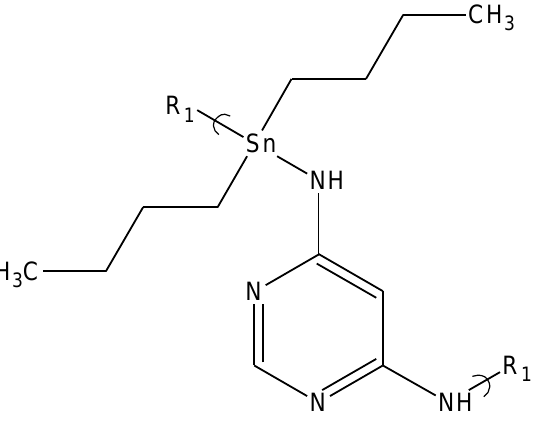
Figure 6. Repeat unit for the product of dipropyltin dichloride and